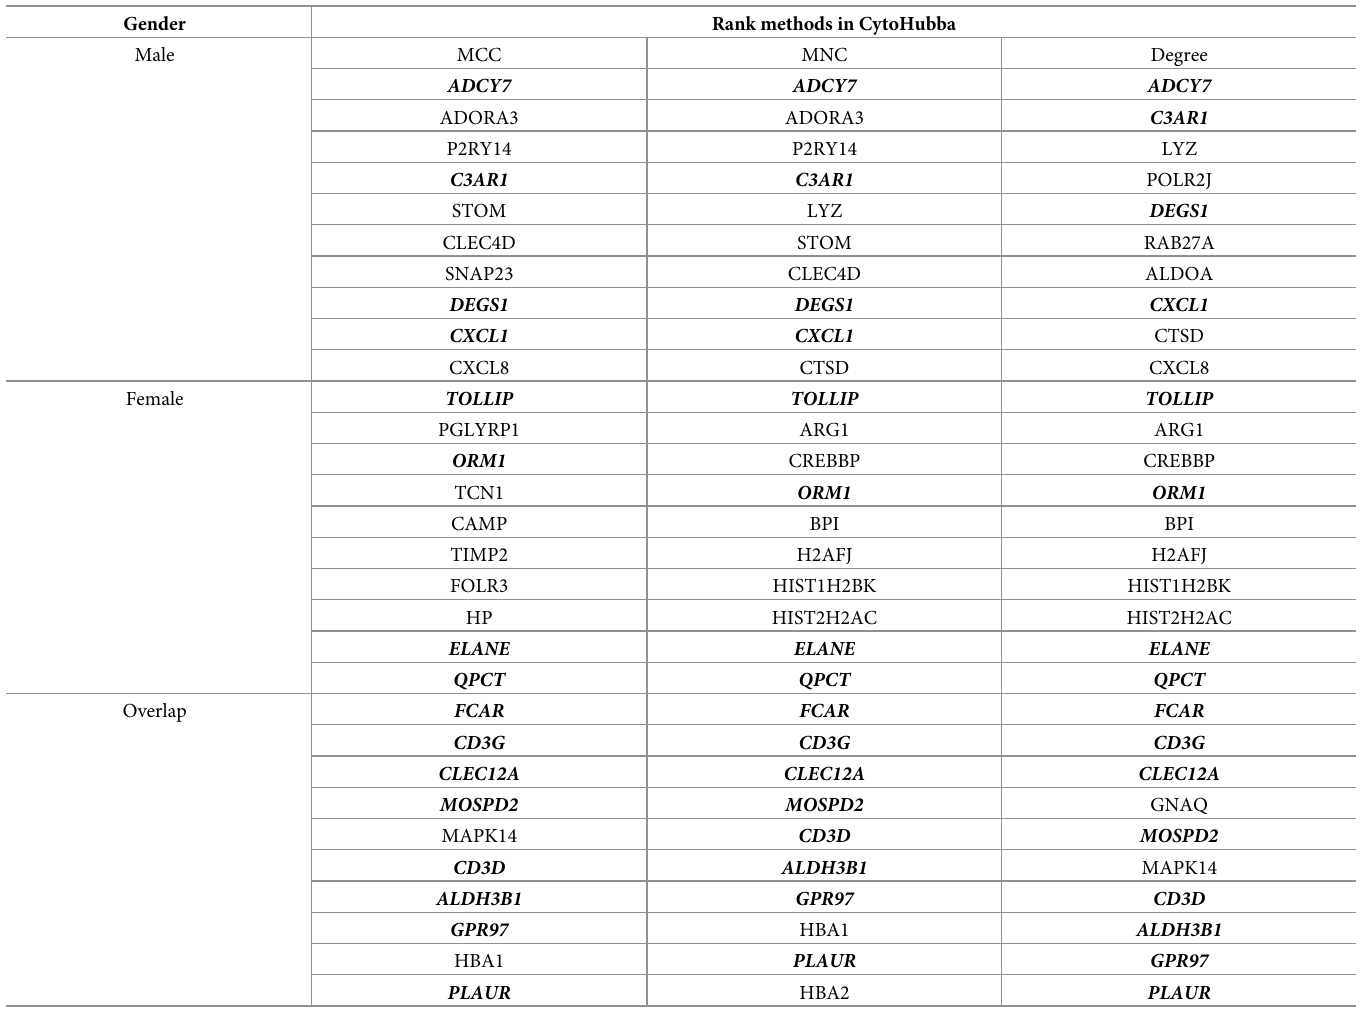
Table 2. Hub genes for highly differentiated expressed genes ranked in Cytohubba plugin of Cytoscape.